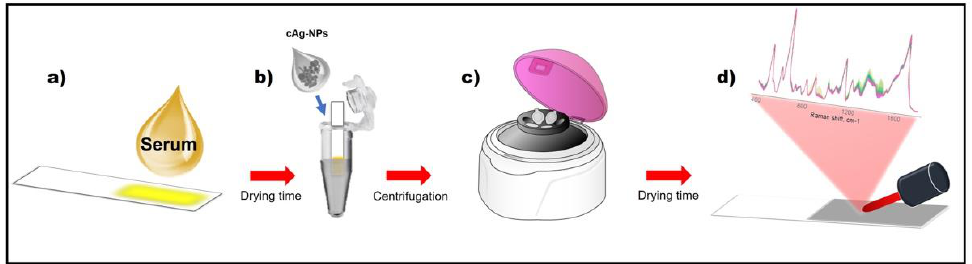
Figure 1. Schematic workflow for CSPP sensing of serum